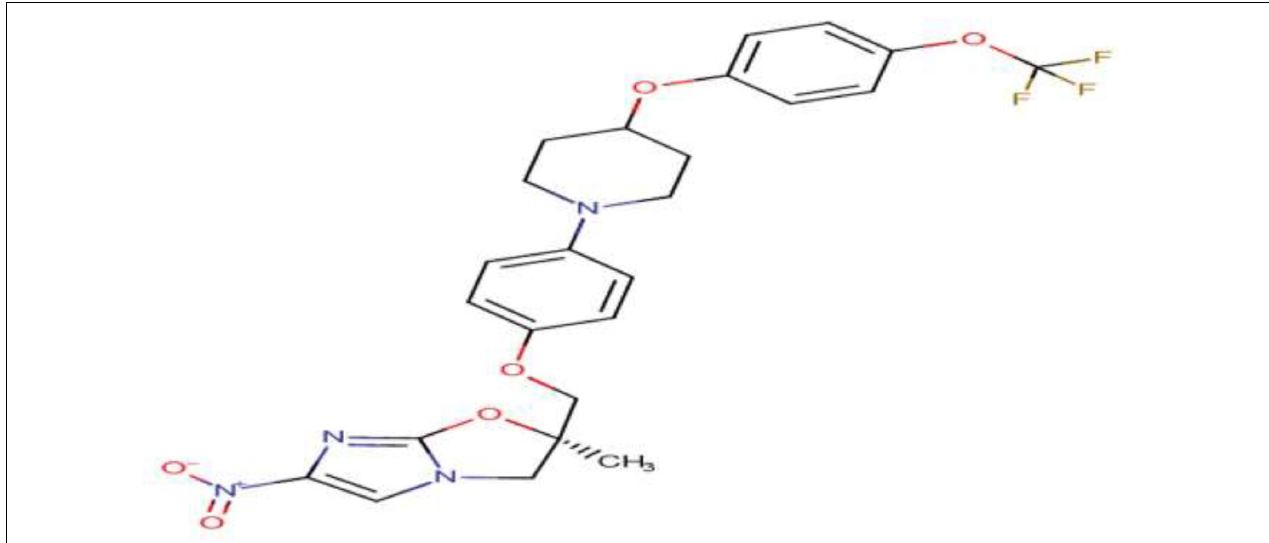
FIGURE 1 | Chemical structure of delamanid (Szumowski and Lynch,